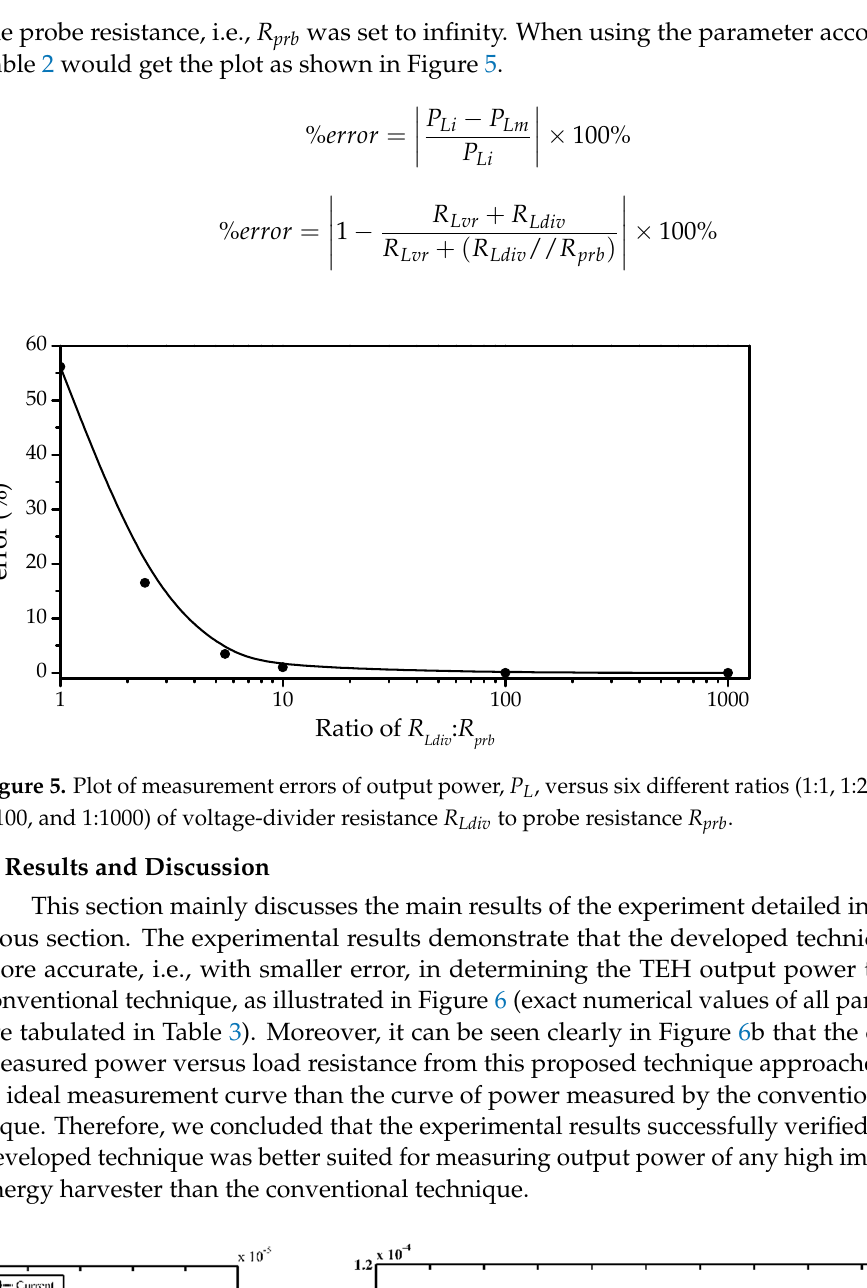
Figure 4. ( a ) Experimental setup test bench; ( b ) voltage signal measured from the developed technique.